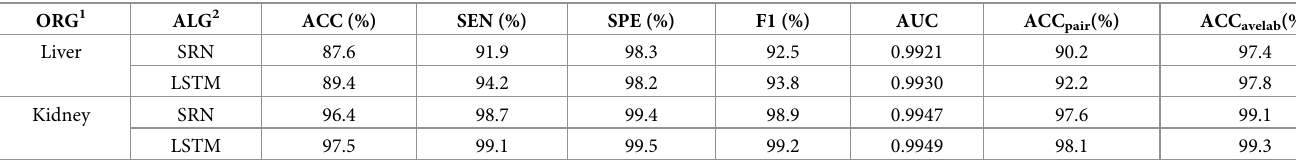
Table 1. Comparison between Att-RethinkNet based on LSTM and SRN algorithms. ORG 1